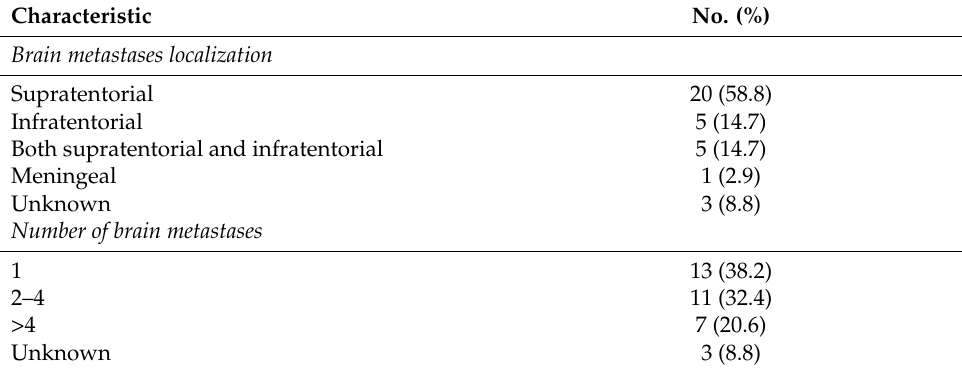
Table 2. Characteristics of brain